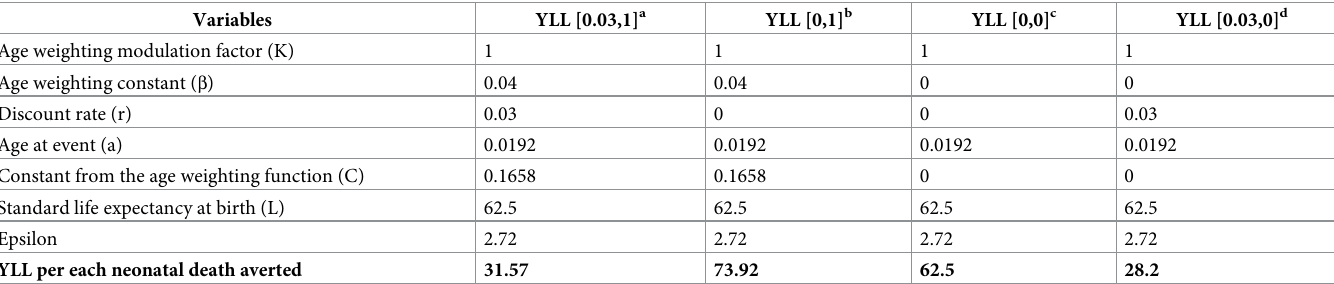
Table 6. Years of life lost (YLL) for each neonatal death using different social value choices.